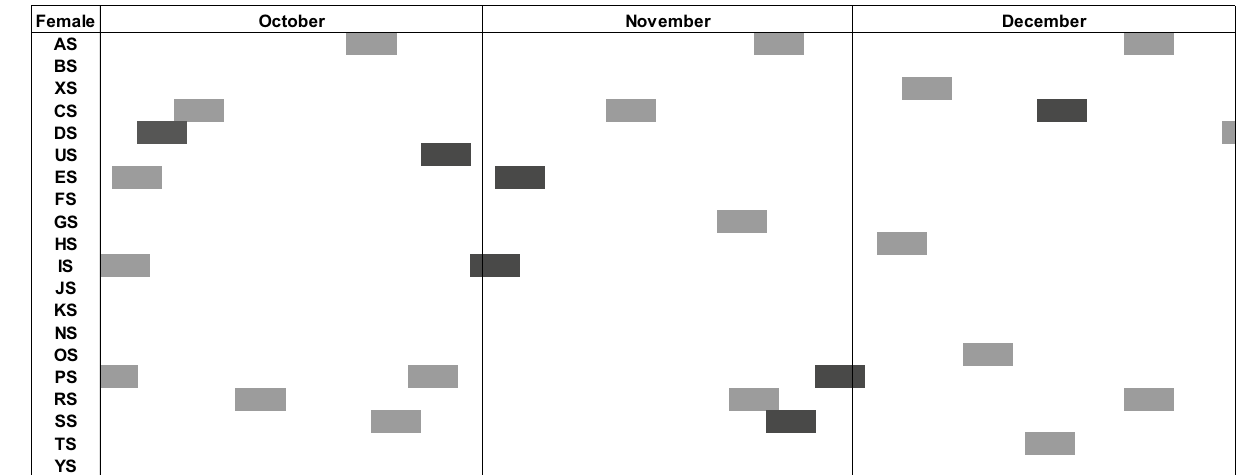
Figure 1. Overlap of fertile phases in group Rambo I during October to December 2006. Grey boxes indicate fertile phases of non-conceptive cycles and black boxes indicate those of conceptive cycles. In both groups, a maximum of three females were in their fertile phase on any given day of the study